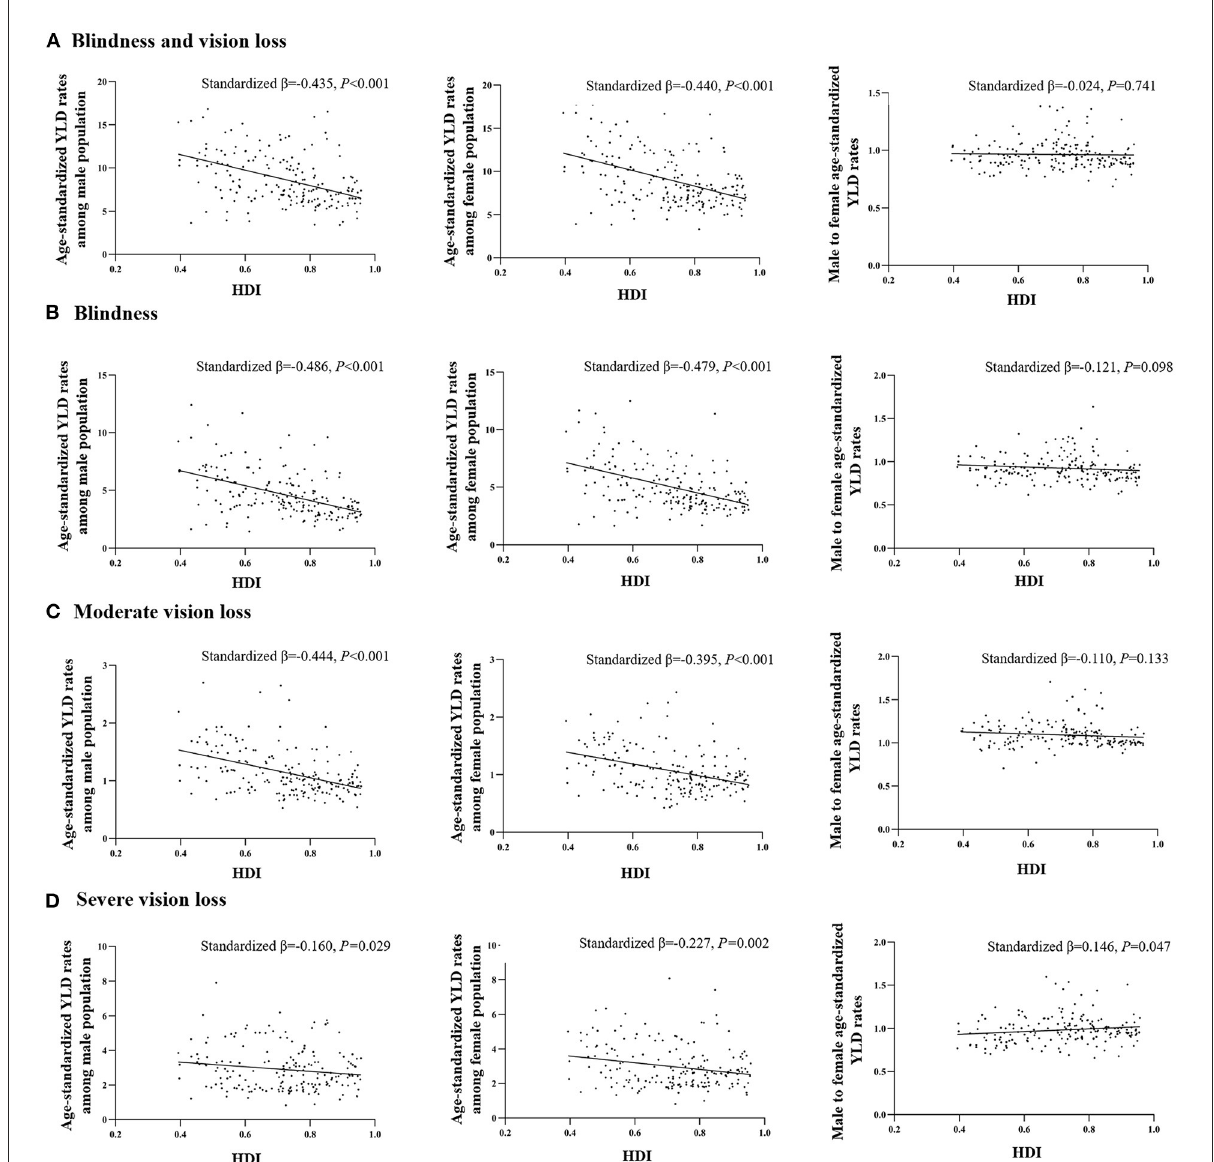
FIGURE5 Association between gender difference of age-standardized YLD rates with HDI. The linear relationships between national age-standardized YLD rates in females and HDI, national age-standardized YLD rates in males and HDI, and national female-to-male age-standardized YLD rate ratios and HDI are presented in the following groups: (A) NPB-related blindness and vision loss, (B) NPB-related blindness, (C) NPB-related moderate vision loss, and (D) NPB-related severe vision loss. NPB, Neonatal preterm birth; YLDs, years lived with disability; HDI, Human Development Index.